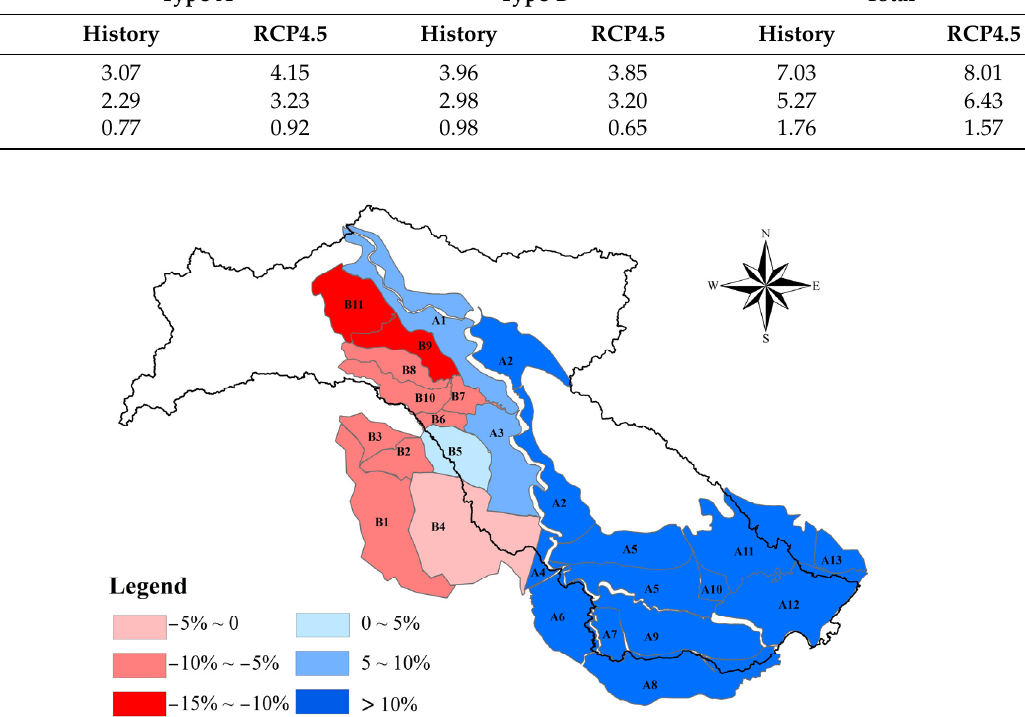
Table 4. The water availability under the historical and future RCP4.5 scenarios (billion m 3 ). Area